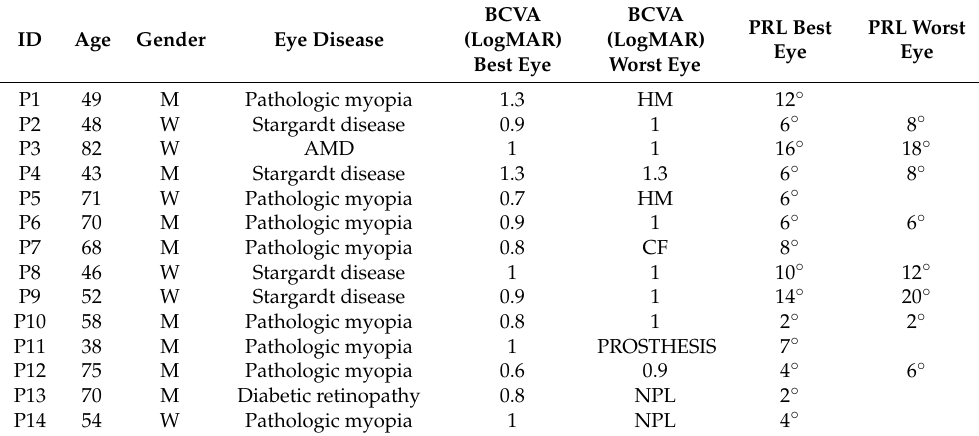
Table 1. Patients with central vision loss characteristics.